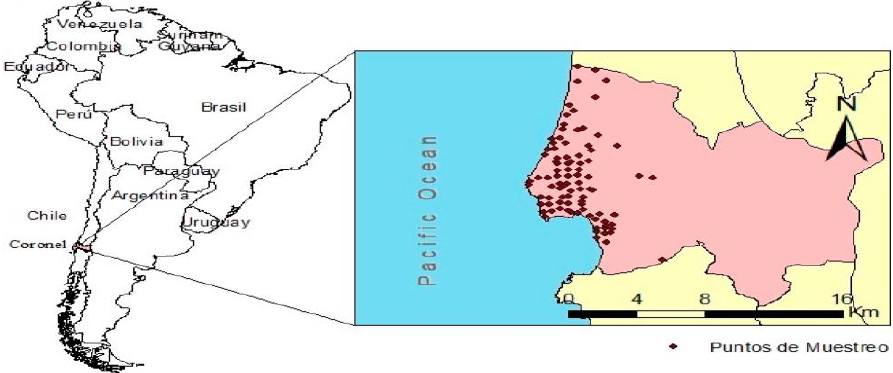
Figure 1. Map of the study area showing the sampling sites in the commune of Coronel,